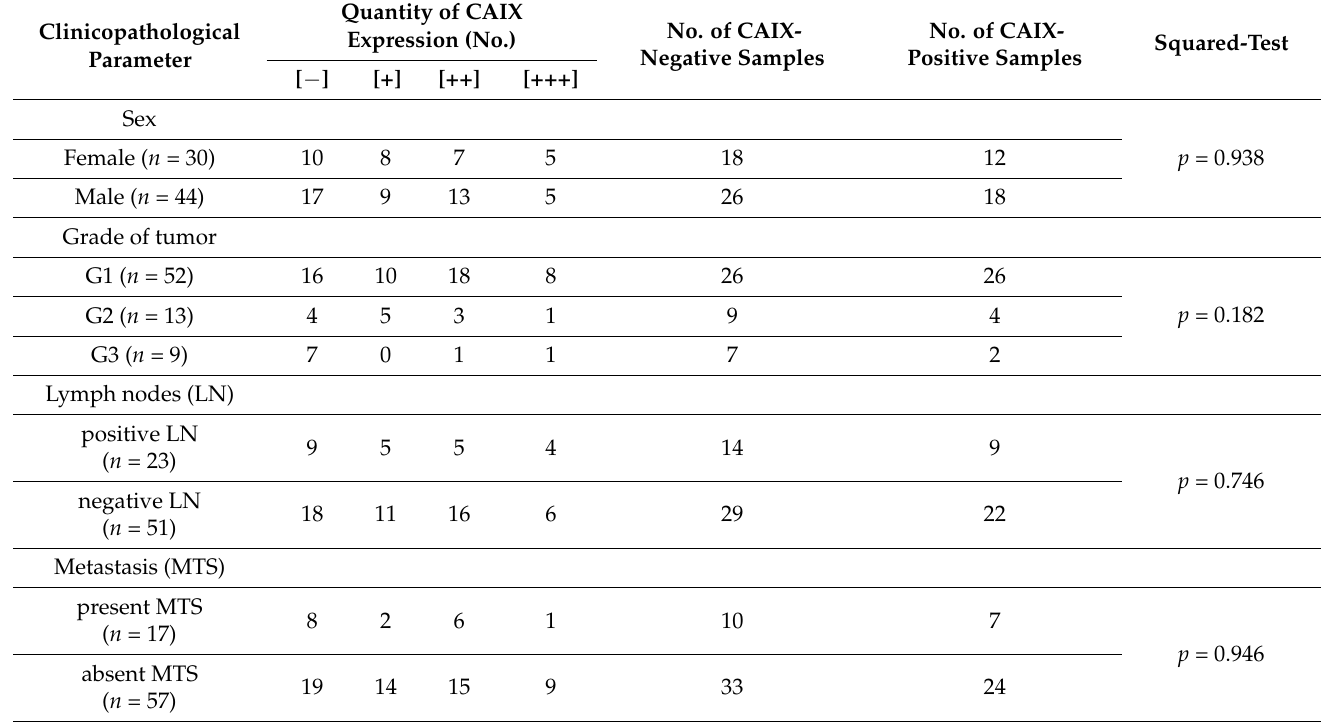
Table 3. Statistical evaluation of CAIX expression in comparison to clinicopathological parameters (sex of patients, grade of tumor, nodal status and absence/presence of metastasis).